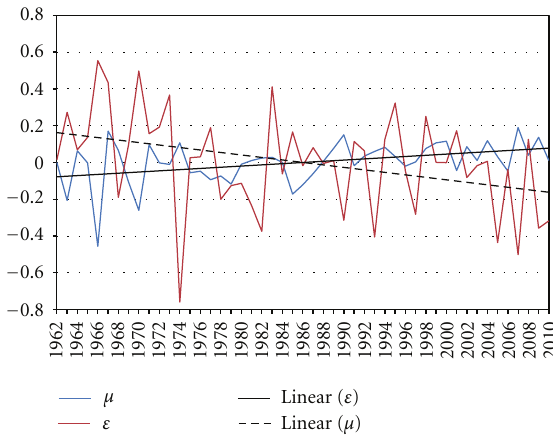
Figure 6: Residuals for AR adjusted temperature and rainfall in April.